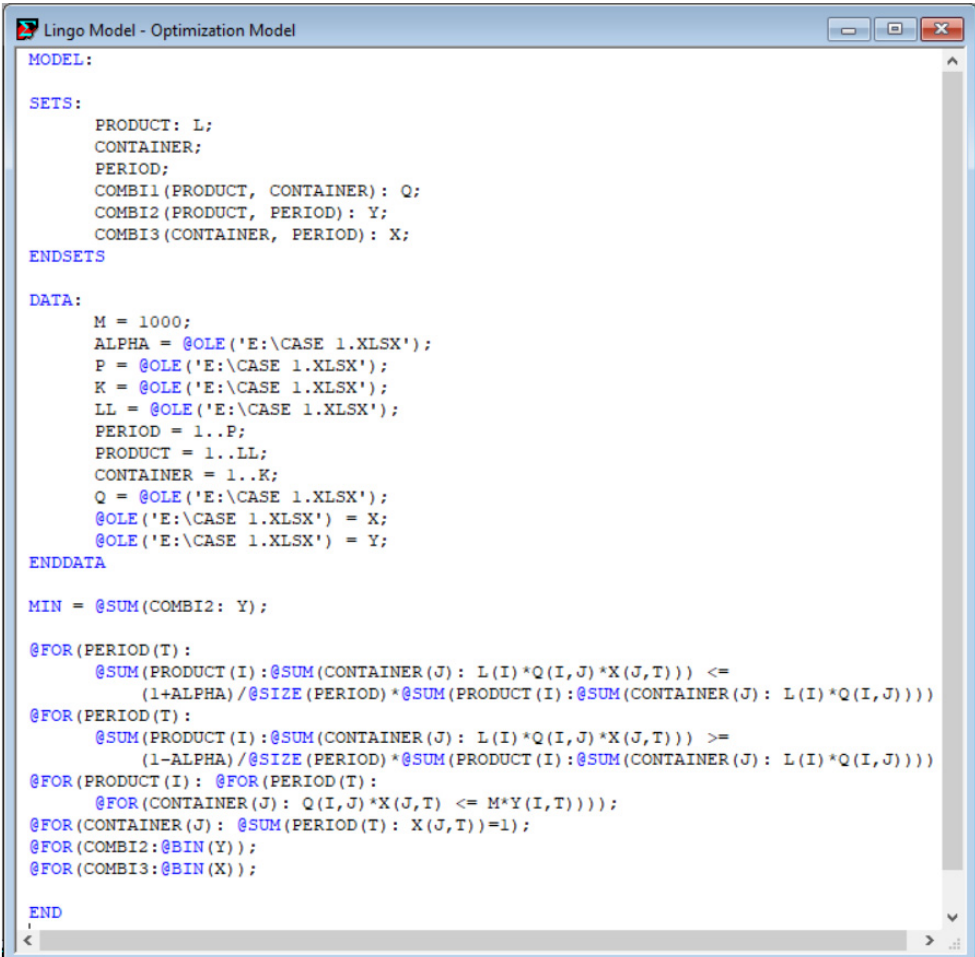
Figure 2. A typical LINGO Model of the proposed mathematical model.